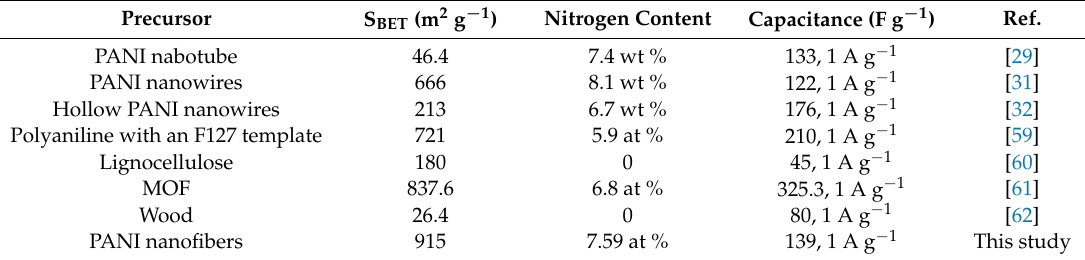
Table 1. Comparison of specific capacitance values with recent reported literature in a three-electrode cell system.